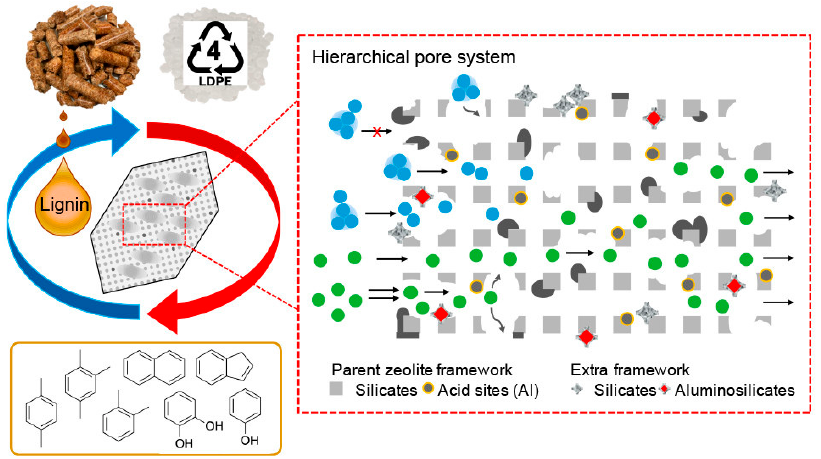
Figure 1. Scheme showing the catalytic conversion of low-density polyethylene (LDPE) with biomass [85].